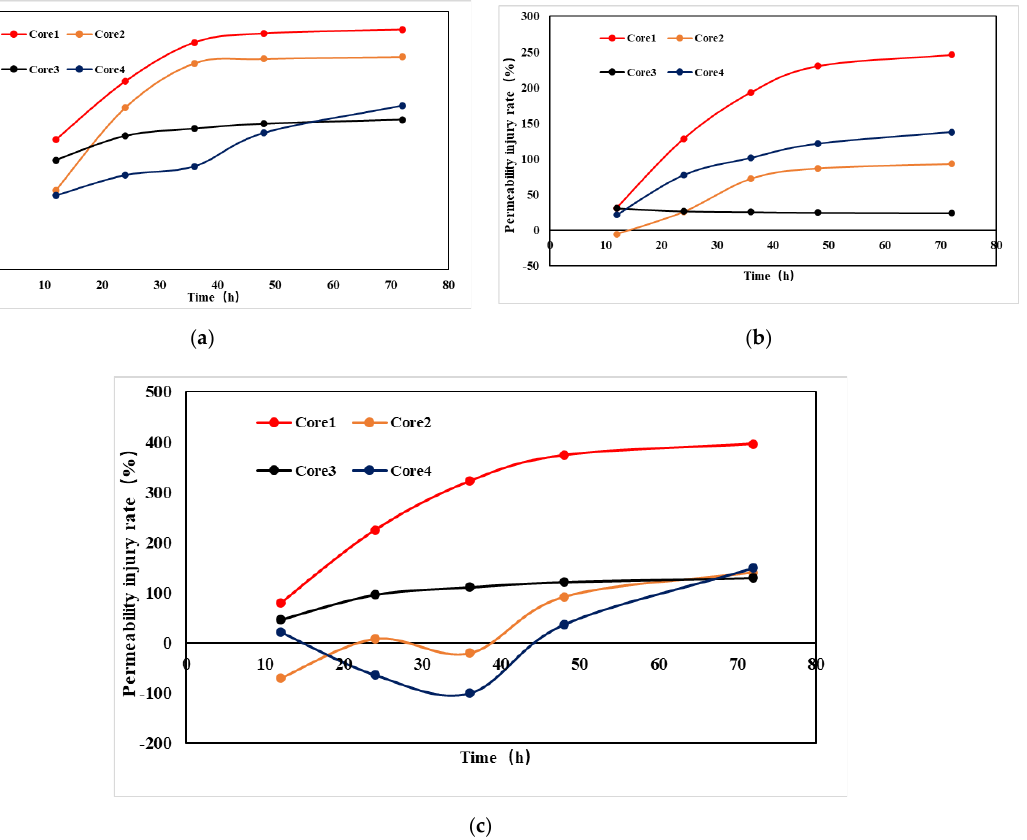
Figure 10. Damage rate curves of varying pore sizes of rock samples under different action times. ( a ) Minor pore; ( b ) Medium pore; ( c ) Macro